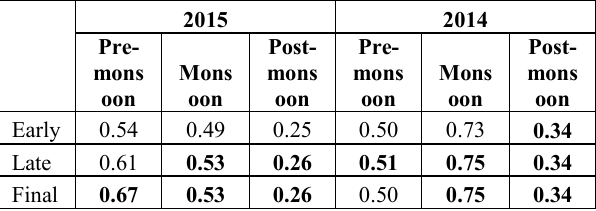
Table 3 Correlation coefficient of GPM-IMERG Early, Late and Final precipitation product with respect to NIH field